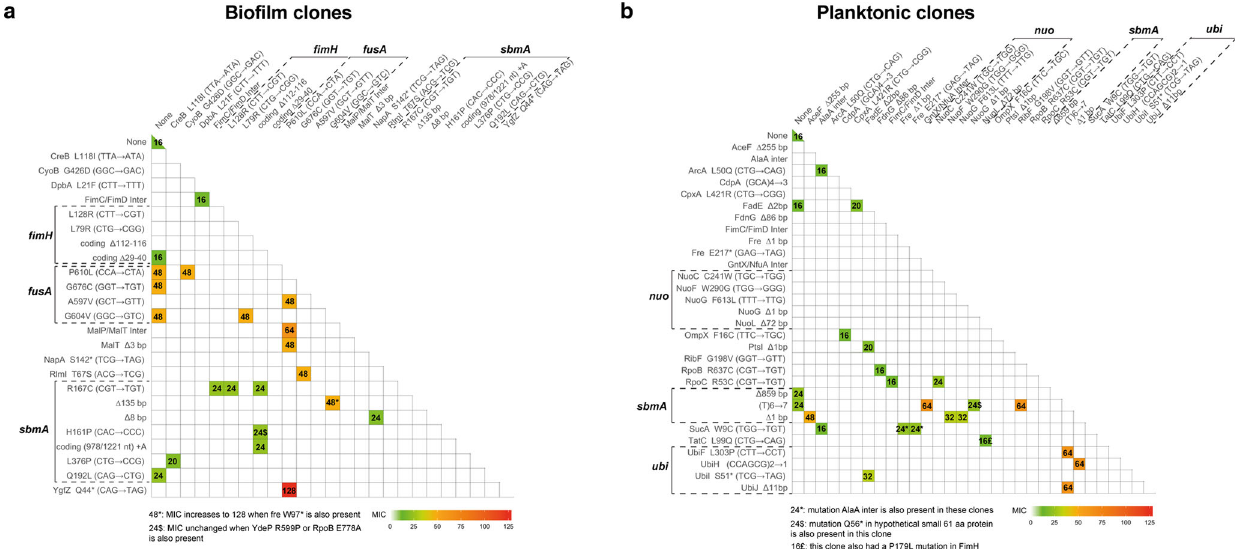
Fig. 5 Association of non-synonymous mutations in sequenced evolved clones and their corresponding MICs to amikacin. Non-synonymous mutations identi fi ed by whole genome sequencing in clones of E. coli coming from AMK intermittently treated bio fi lm ( a ) and planktonic ( b ) populations. MICs are expressed in µ g/mL. MIC of the ancestor strain is 16 µ g/mL and is shown in the fi rst top left cell. In a and b the fi rst column actually corresponds to clones that had a unique mutation in the indicated genes. The presented information is extracted from clone sequencing data presented in supplementary Data